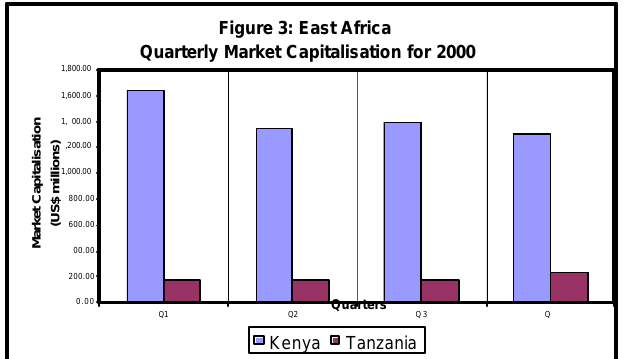
Figure 3: East Africa Quarterly Market Capitalisation for